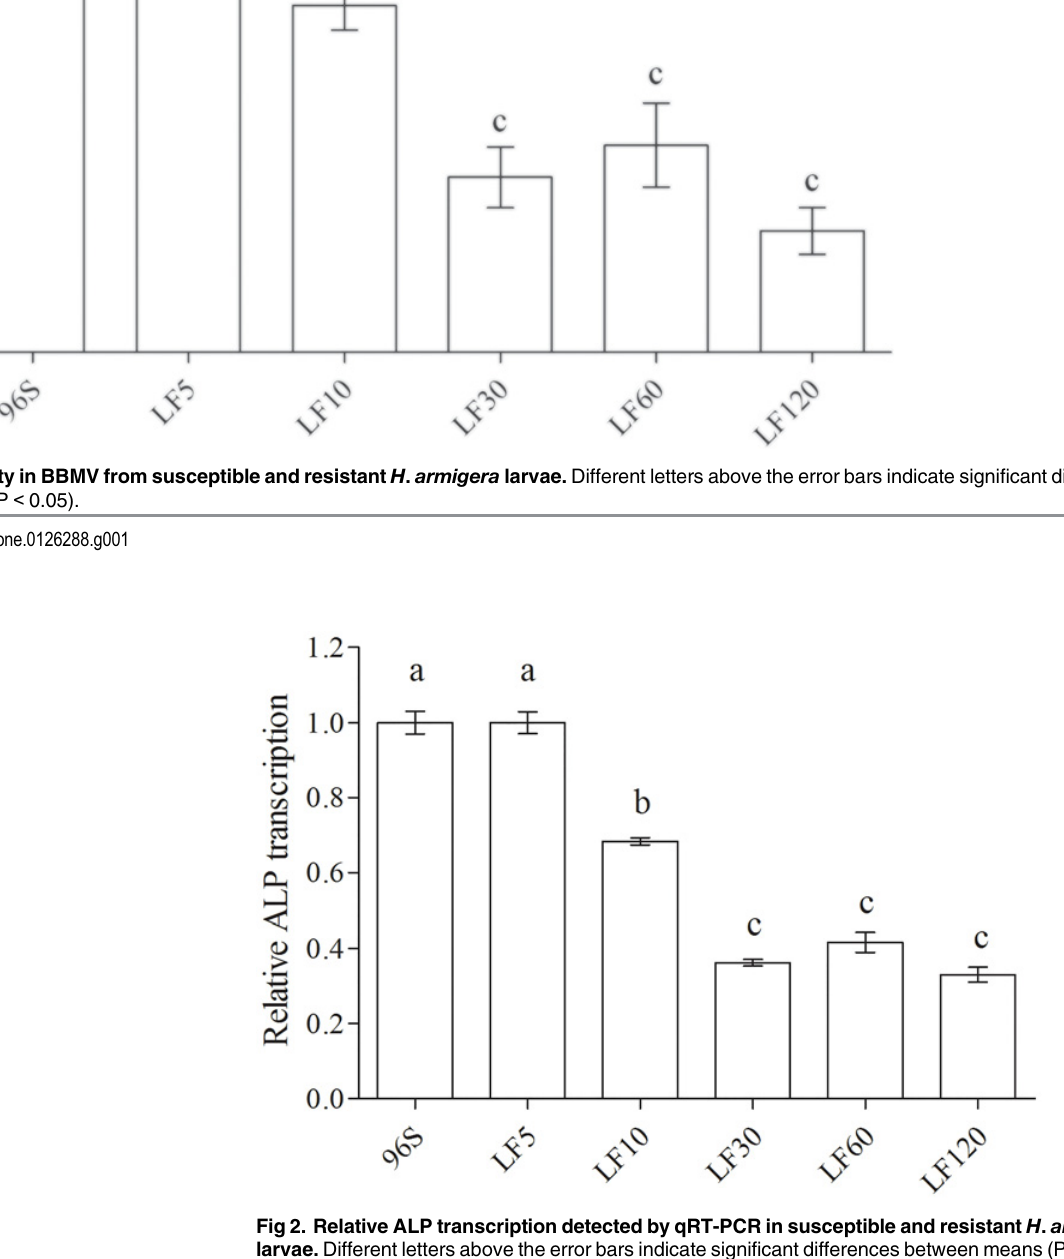
PLOS ONE | DOI:10.1371/journal.pone.0126288 April 17,